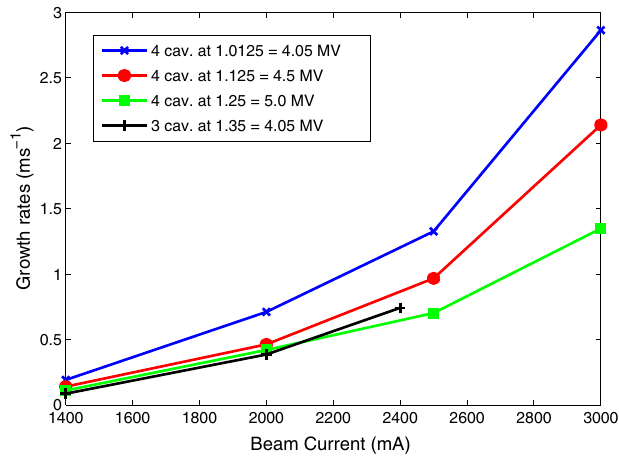
FIG. 8. (Color) Growth rates for a different number of station and gap voltage for the LER.